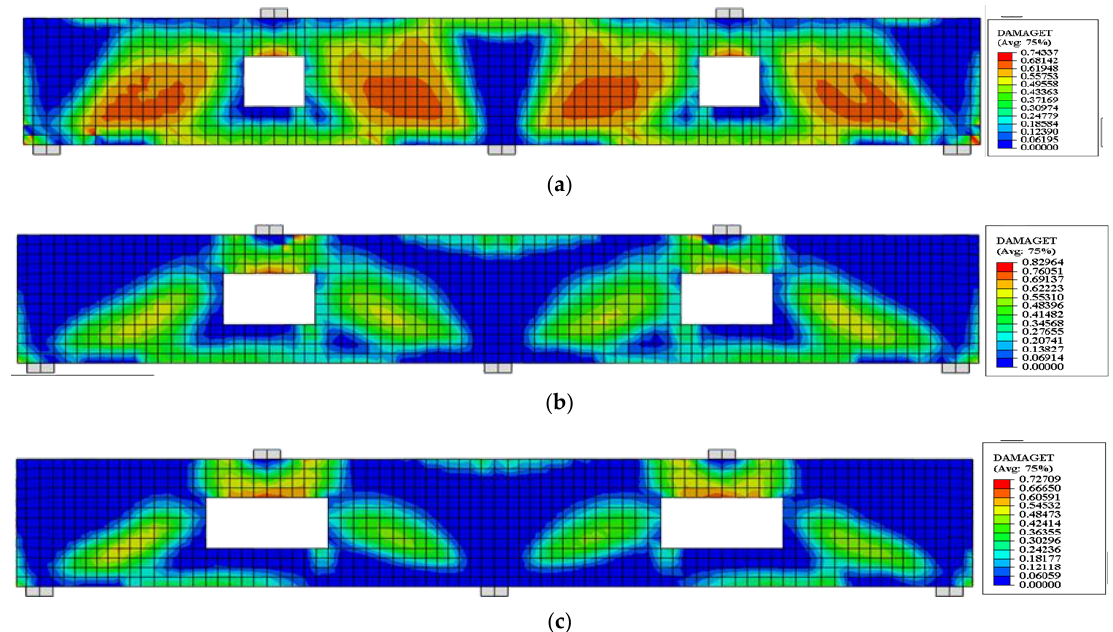
Figure 16. Effect of ratios of the opening dimensions on the FE crack pattern for the strengthened RCCDBs. ( a ) CDB – O – S- R1.0; ( b ) CDB – O – S-R1.5; ( c ) CDB – O – S-R2.0. R1.0; ( b ) CDB–O–S-R1.5; ( c )